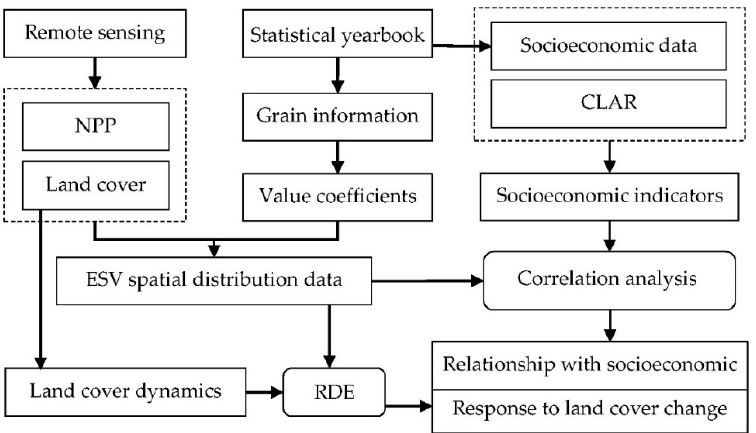
Figure 2. The technical flow chart in this study. CLAR: county-level administrative region; NPP: net primary productivity; RDE: response degree of ecosystem service value relative to land cover change.